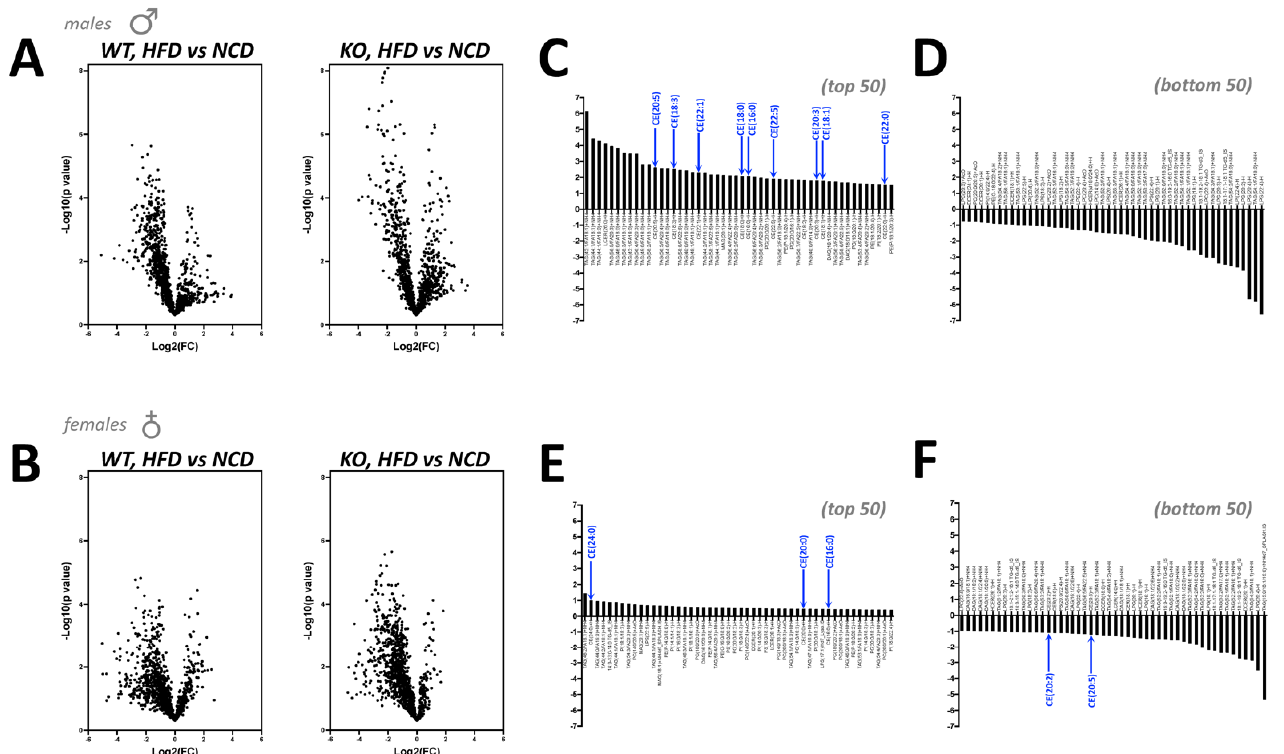
Figure 6. Lipidomics of iWAT in Ppara fl/fl and Ppara FatKO mice. Lipidomics of iWAT using liquid chromatography – mass spectrophotometry (LC mass spec) represented as volcano-plot analysis in male ( A ) and female ( B ) Ppara FatKO and Ppara fl/fl mice on high-fat (HFD) or normal-chow (NCD) diets. Organization of the top 50 and bottom 50 most-changed lipids in male ( C , D ) and female ( E , F ) Ppara FatKO and Ppara fl/fl mice. The blue arrows identify cholesterol esters. (male n = 7 NCD and n = 8 HFD, Ppara fl/fl ; female n = 6 NCD and n = 4 HFD, Ppara fl/fl ; male n = 7 NCD and n = 8 HFD, Ppara HepKO ; female n = 6 NCD and n = 4 HFD, Ppara HepKO ).